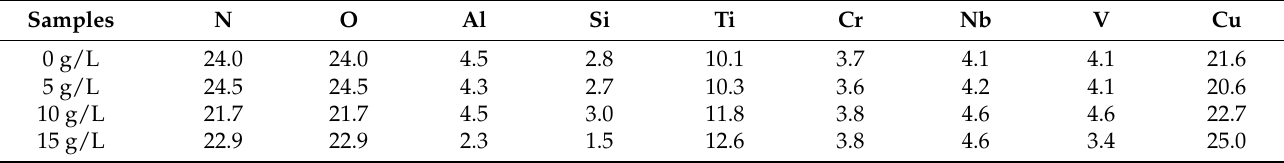
Figure 2. The surface morphologies of MAO-Cu/Cu-(HEA)N composite coatings with different CuSO 4 concentrations:( a ) 0 g/L; ( b ) 5 g/L; ( c ) 10 g/L; and ( d ) 15 g/L. Table 2. The composition of MAO-Cu/Cu-(HEA)N composite coatings with different CuSO 4 concentrations.